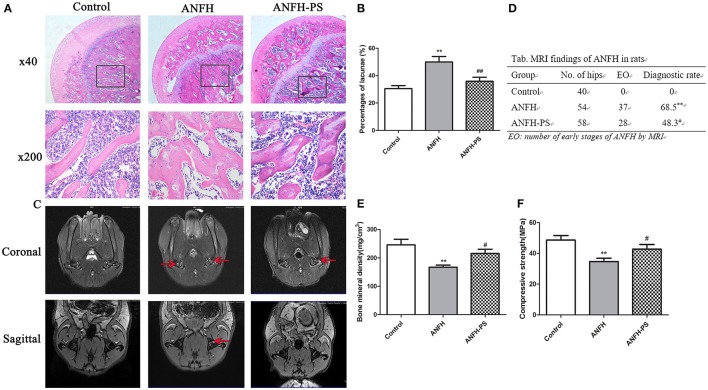
Pravastatin (PS) improved Dex-induced ANFH at histopathological and MRI levels. (A) Representative photographs of HE staining on day 30; boxed regions (×40) are shown at higher magnification (×200) below. (B) Pravastatin reduced the percentage of empty lacunae in Dex-induced ANFH as compared with the untreated ones. (C) Representative photographs of MRI on day 30. The red arrows exhibited STIR high signal which was identified as fat appearance and potential femoral head osteonecrosis. (D) The incidence of ANFH by MRI scan in rats. (E) Femoral bone mineral density detection. (F) Femoral head compressive strength detection. Values are expressed as the mean ± SEM of three independent experiments. n = 5 per group. **p < 0.01 vs. Control; #p < 0.05, ##p < 0.01 vs. ANFH.